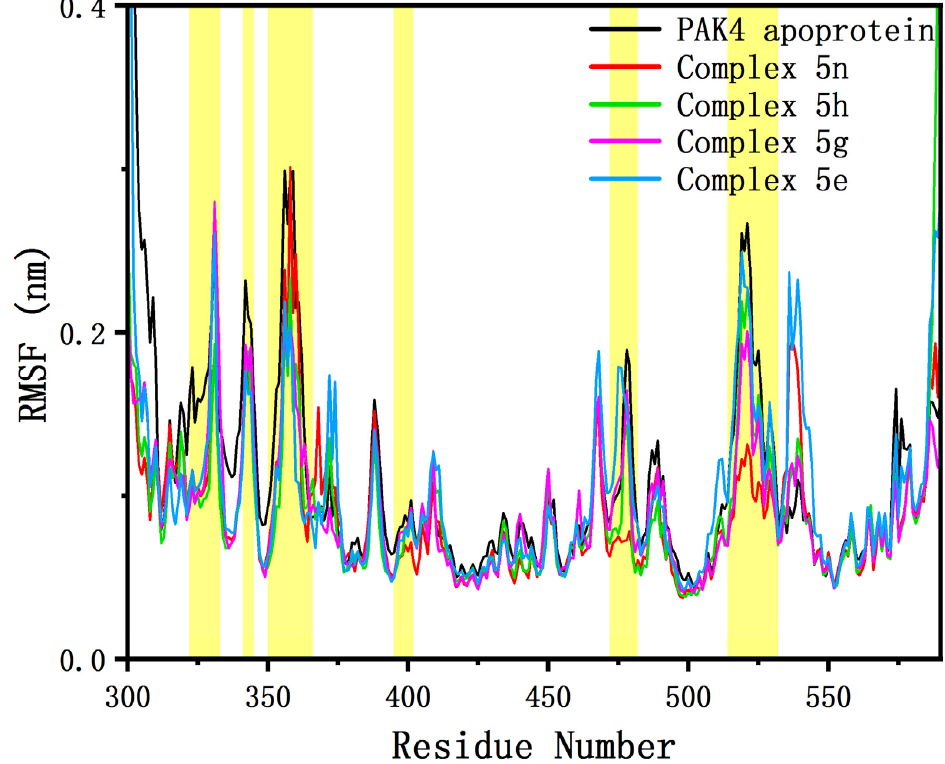
Figure 4. The comparisons of the RMSF of four complexes with the PAK4 apoprotein. The re- gions marked in yellow background are, in order: Asp322-Gly333, Arg341-Lys345, Lys350-Glu366, Met395-Ala402, Arg472-Met482, and